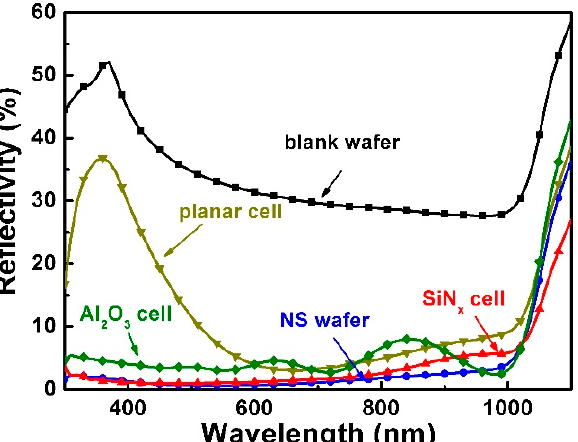
Figure 2. SEM images of silicon nanostructures with passivation layers of ( a , b ) 80 nm SiN X and ( c , d ) 100 nm Al 2 O 3 . The Al 2 O 3 layer filled the gaps in the silicon nanostructures through deposition.